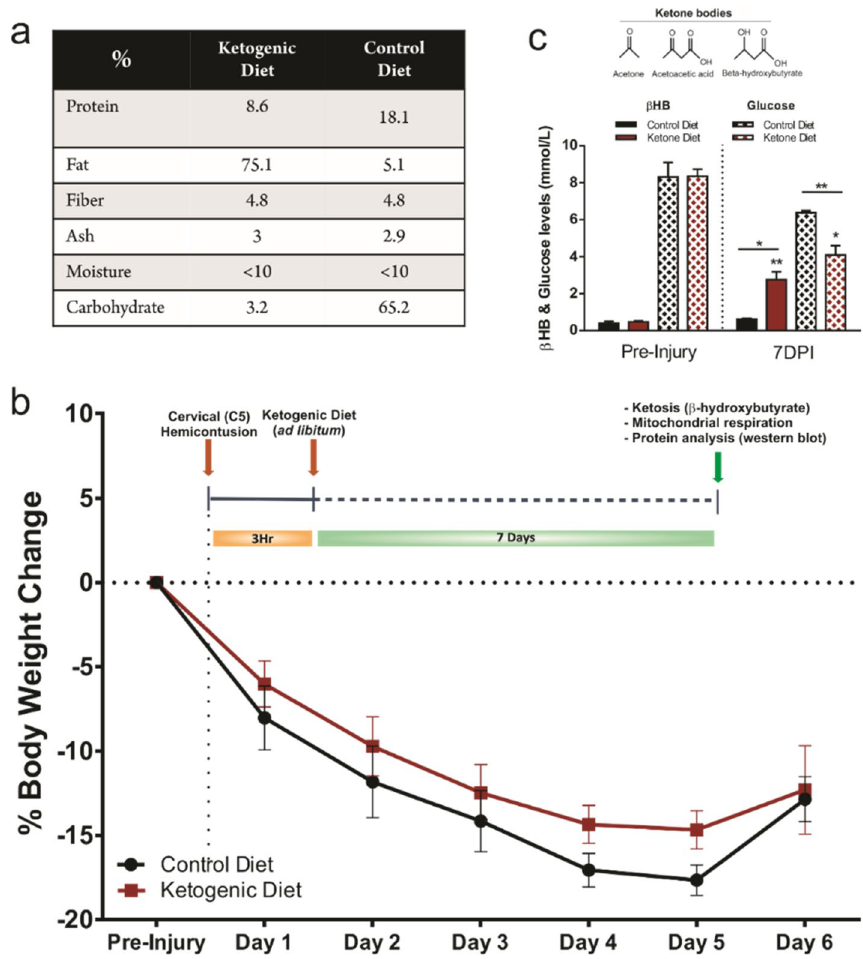
Figure 1. ( a ) Table showing the control and ketogenic diets breakdown (%) (CD: F5960, Bioserv; KD: F5848, Bioserv). ( b ) Experimental timeline and percentage weight change along the experiment. Data are the means ± SEM. c) Blood ketone (β-hydroxybutyrate) levels increased and glucose levels decreased when consuming KD ad libitum. Data are the means ± SEM. Student’s t-Student